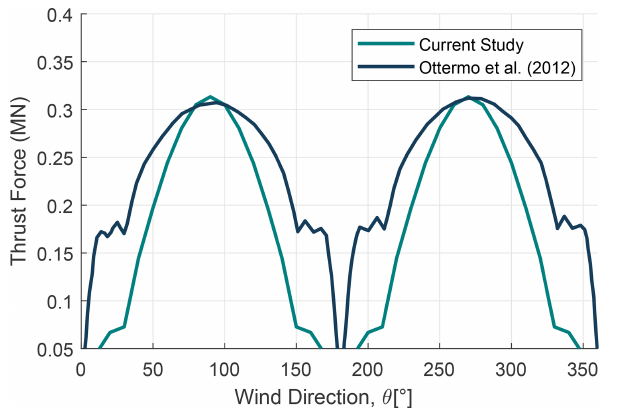
Figure 11. Parked load comparison with existing